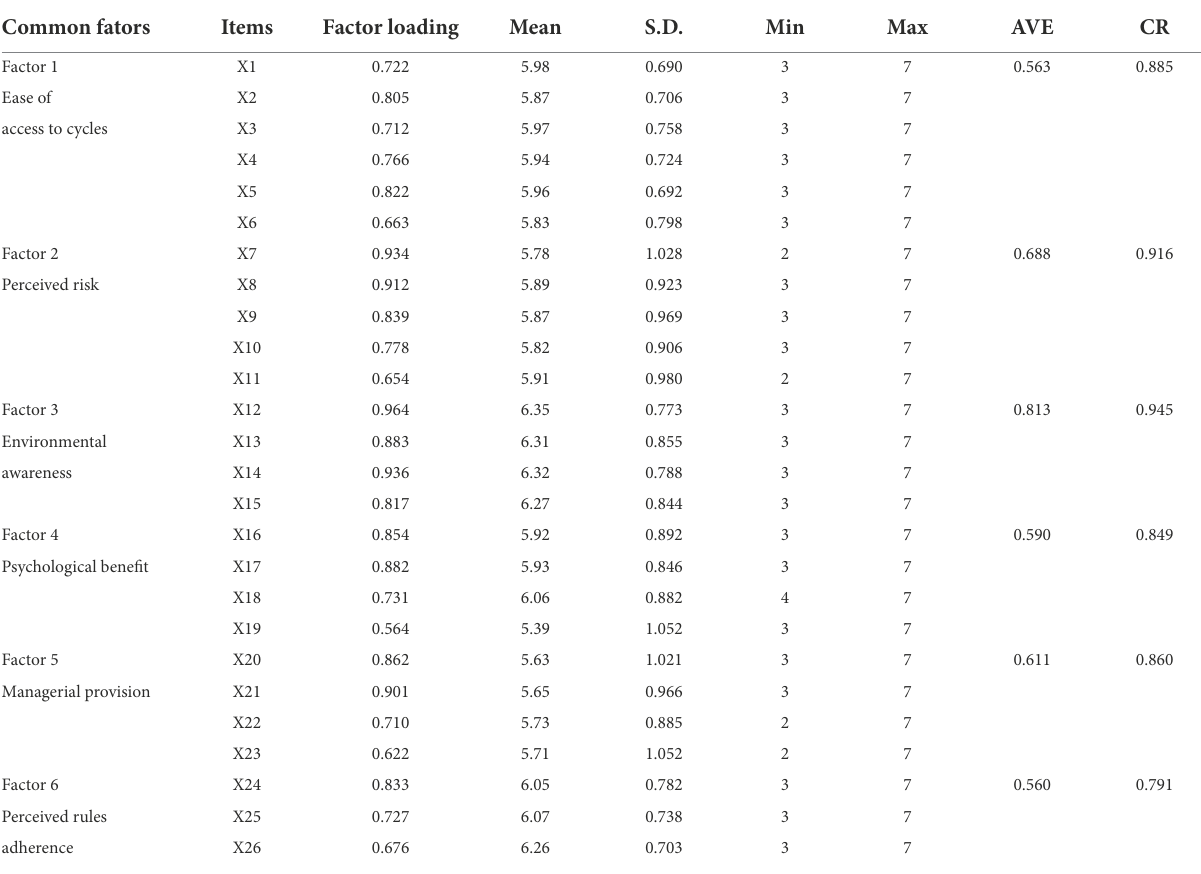
TABLE 3 The results of CFA ( n = 234).